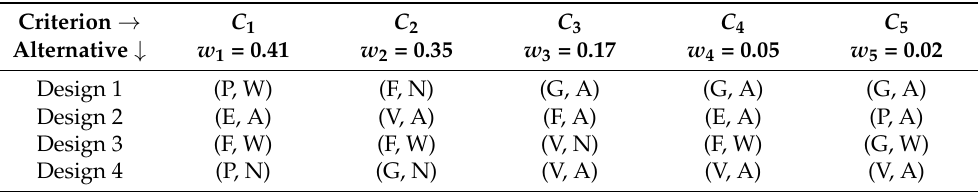
Table 9. Decision matrix of managers.